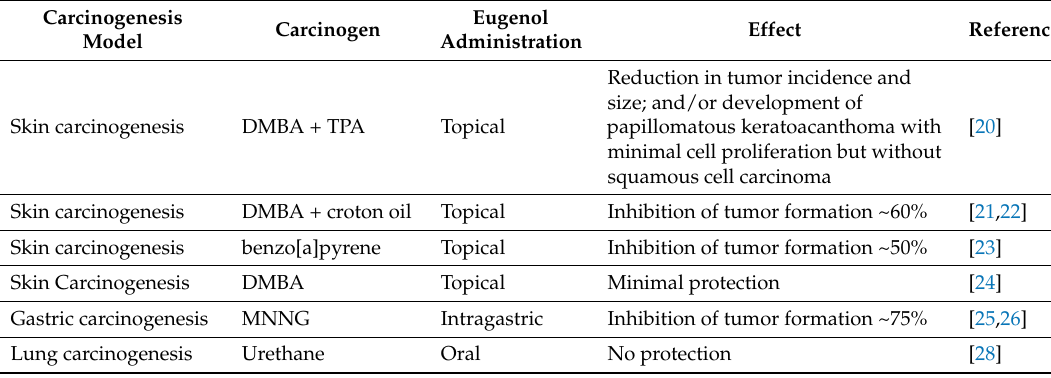
Table 1. Summary of anti-carcinogenic effect of